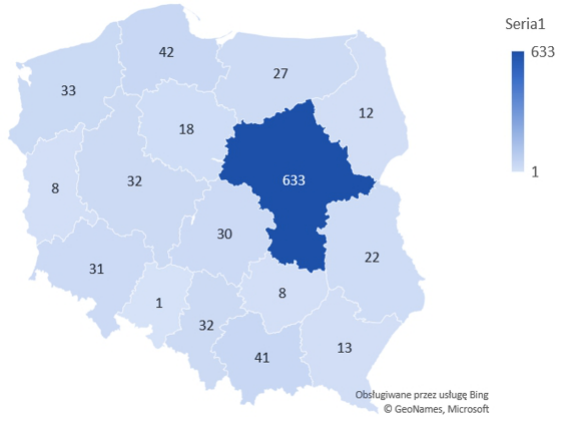
Figure 1. Regional distribution of respondents’ living area.